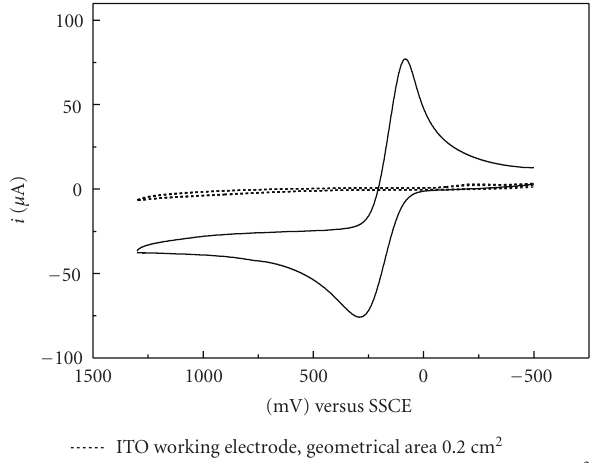
Figure 8: Cyclic voltammetry of approximately 1 × 10 − 3 M recorded in ACN/TBAPF 6 0.1 M on GC (solid line) and Co(DTB) 2+ 3 on ITO (dotted